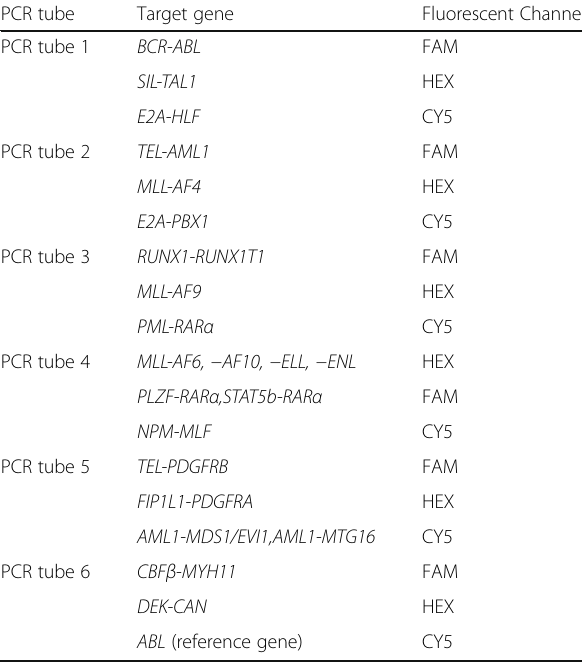
Table 3 PCR reaction tube